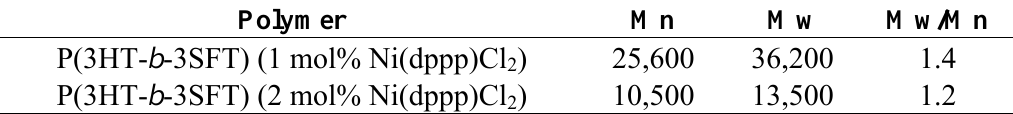
Table 1. Summary of GPC measurements of P3HT prepolymer and diblock copolymer, P(3HT- b -3SFT).